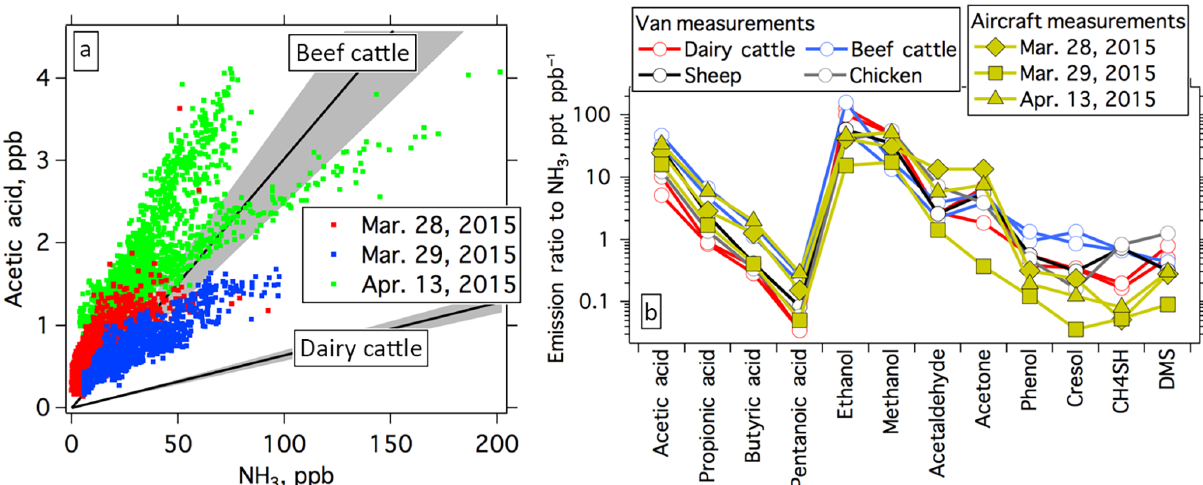
Figure 7. (a) Scatterplot of acetic acid versus NH 3 from the three SONGNEX flights in northeastern Colorado. The two black lines and gray-filled areas indicate emission ratios of acetic acid to NH 3 from beef feed yards and dairy farms determined from the mobile laboratory measurements, respectively. (b) Comparison of enhancement ratios of VOCs to NH 3 between mobile laboratory and aircraft measurements in northeastern